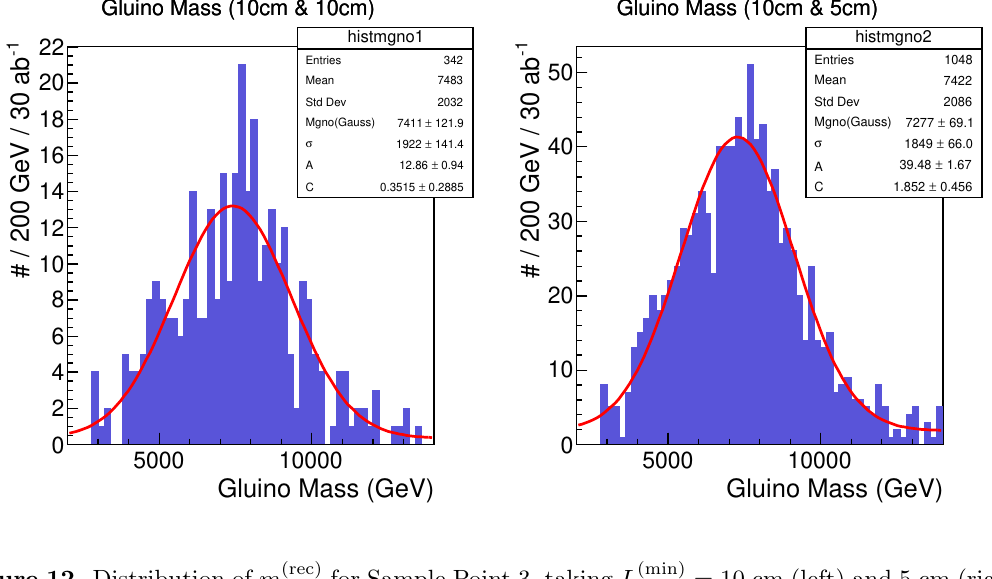
for Sample Point 3, taking L (min) = 10 cm (left) and 5 cm (right) ~ g T; 2